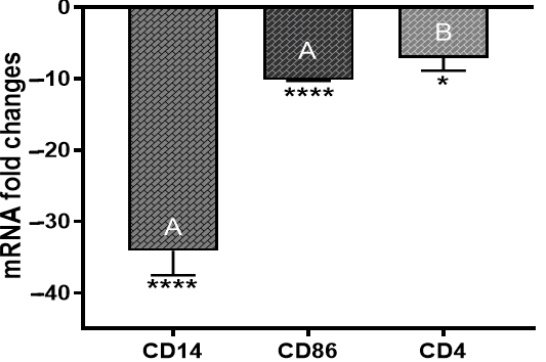
Figure 10. CD14, CD86, and CD4 mRNA fold-change following a 24 h co-culture of ST285 with monocytes ( n = 3), compared to control monocytes. The innate and adaptive RT 2 gene profiler arrays were used to determine changes in gene expression. The symbols represent the p -value for Tukey’s test (one-way ANOVA) where * p < 0.05 and *** p < 0.02.